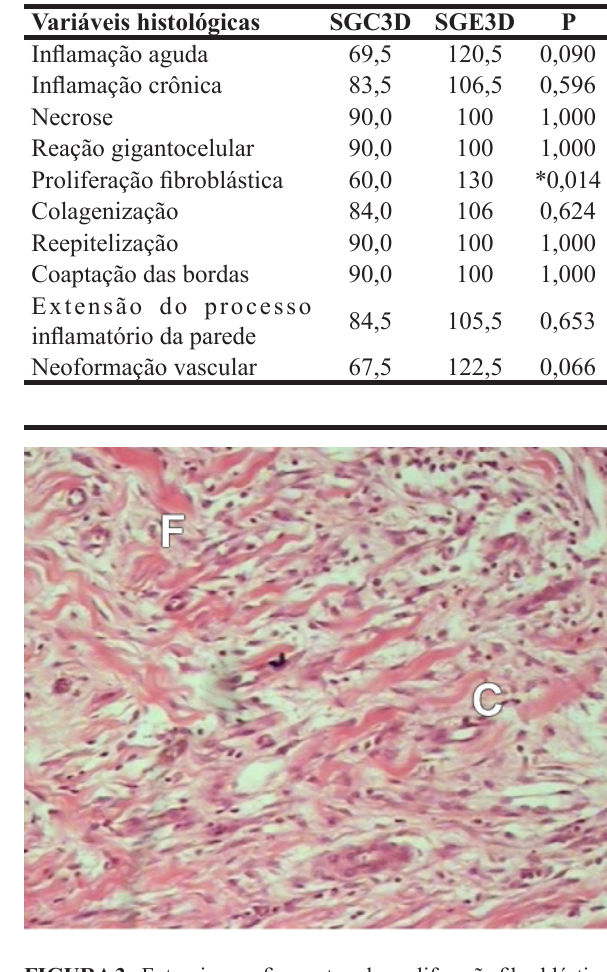
FIGURA 3 - Fotomicrografia mostrando proliferação fibroblástica e colagenização no 3º dia de P.O. animal do grupo GE3D (Coloração HE, aumento de 100x) mostrando proliferação fibroblástica. Nota: C = colágeno, F =